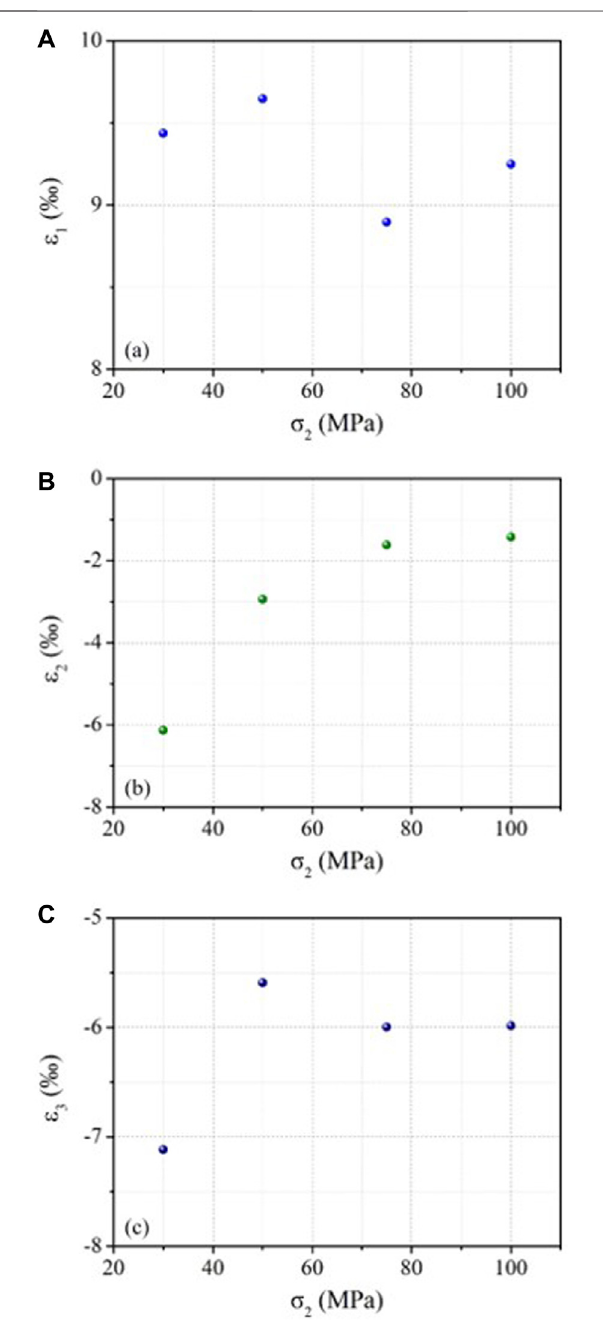
FIGURE 10 | Strain characteristics of granite samples adopted in the true triaxial experiment. (A) ε 1 versus σ 2 , (B) ε 2 versus σ 2 , and (C) ε 3 versus σ 2 .